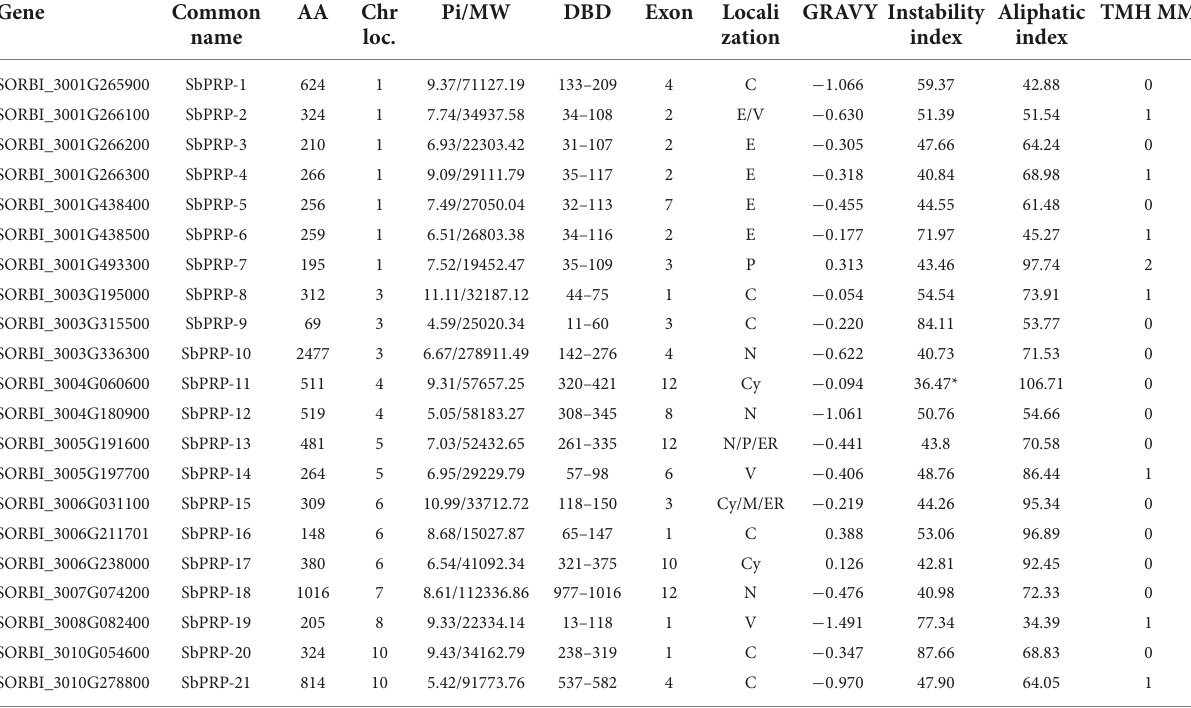
TABLE 1 List of identified PRPs exhibiting chromosomal location, sub group, length, DNA binding domains (DBD), molecular weight, (MW), iso-electric point (pI), GRAVY, no. of exons, localization, and instability and aliphatic indexes.